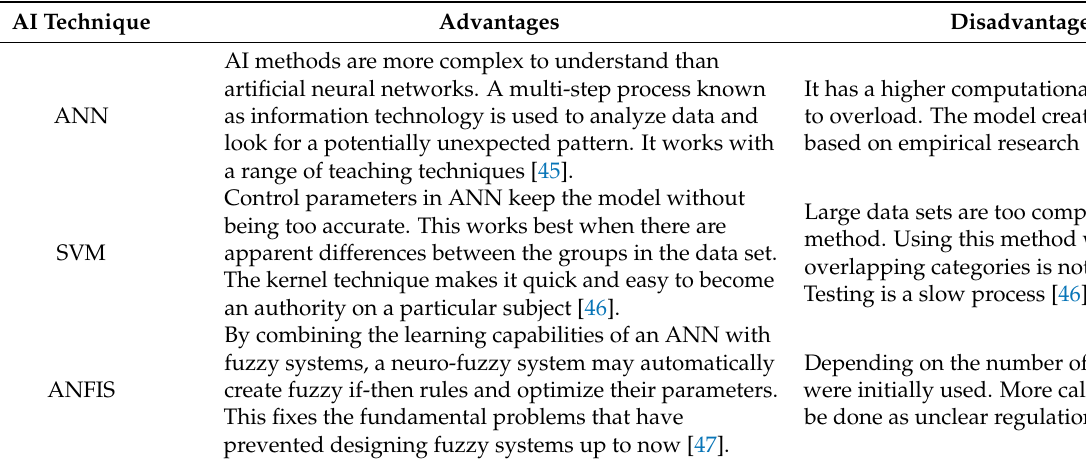
Table 3. Summary of AI Methods on smart